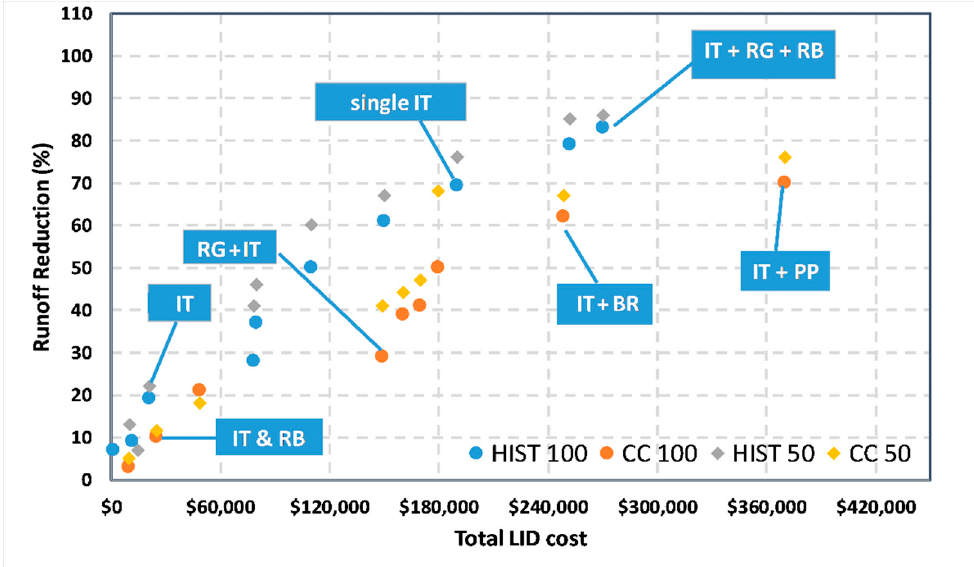
Figure 10 . Total runoff reduction and associated costs of LIDs for hist- and CC-storm scenarios . Figure 10. Total runoff reduction and associated costs of LIDs for hist- and CC-storm